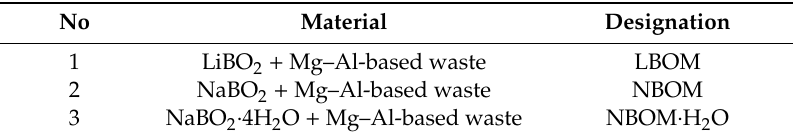
Table 1. Designation of the investigated